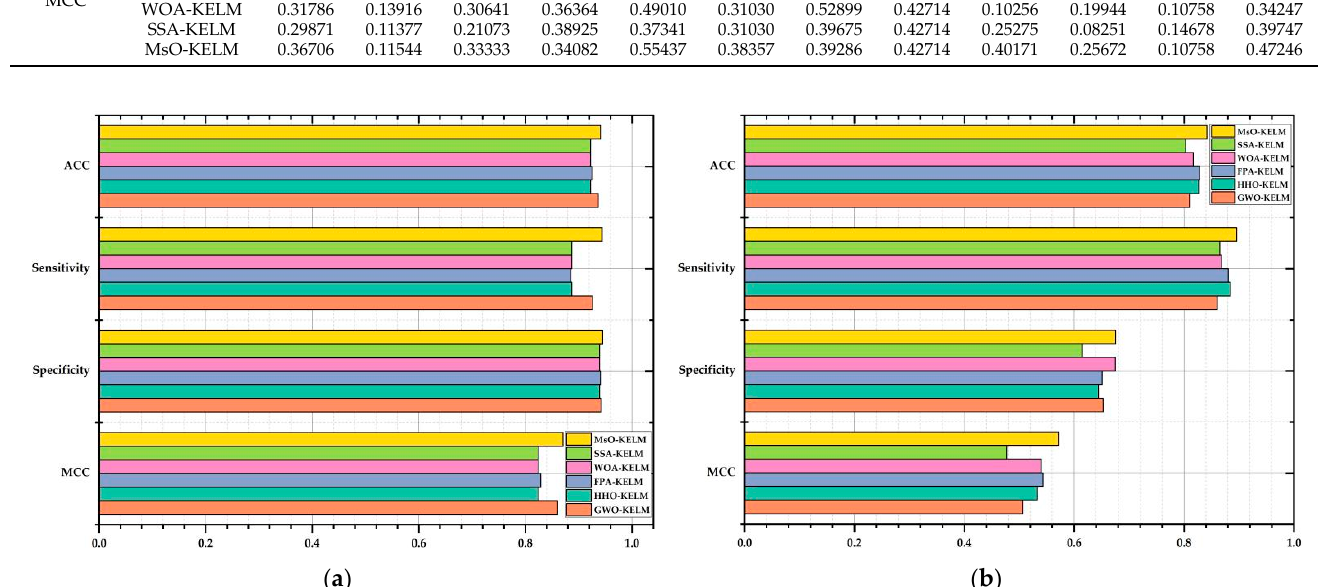
Figure 5. The figure of evaluation metric results on Breast Cancer and Parkinson. ( a ) the evaluation criterion result on Breast Cancer; ( b ) the evaluation criterion result on Parkinson.